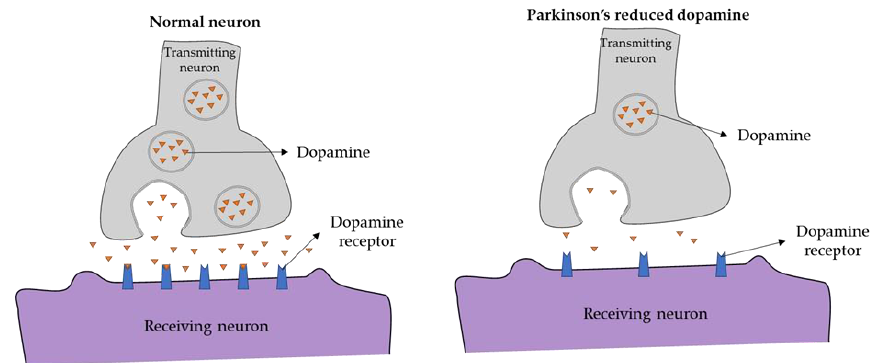
Figure 1. Synaptic terminal in (left) healthy controls and (right) PD patients.